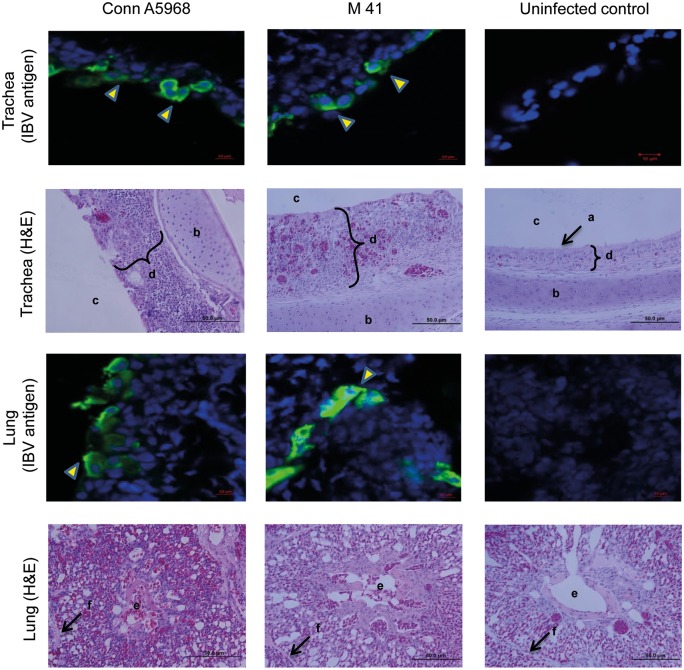
IBV M41 and Conn A5968 infections were evident by both IBV antigen demonstration and histological changes of the trachea and lungs.Six days old chickens were infected intra-tracheally with IBV M41 (n = 5) and Conn A5968 (n = 5) strains (2.75×104 EID50 per bird) with uninfected controls (n = 4) and lung and tracheal tissues were collected in OCT and 10% formal saline at 4 dpi. Five μm frozen sections were immunostained for demonstrating IBV antigen and paraffin embedded sections were H&E stained. IBV N antigen in the tracheal and lung sections were stained using DyLight® 550 fluorescent (arrow heads). In the IBV infected trachea, complete loss of cilia (a) and thickening of the mucosa with inflammatory cell infiltration can be seen compared to the control trachea. In the IBV infected lungs, inflammation leading to reduced air exchange areas and reduced lumen of parabronchi are visible. Also, the difference of mucosal thickening in the infected and uninfected trachea is shown (d). a = cilia, b = tracheal cartilage, c = tracheal lumen, d = mucosal layer, e = parabronchial lumen and f = interparabronchial septum.